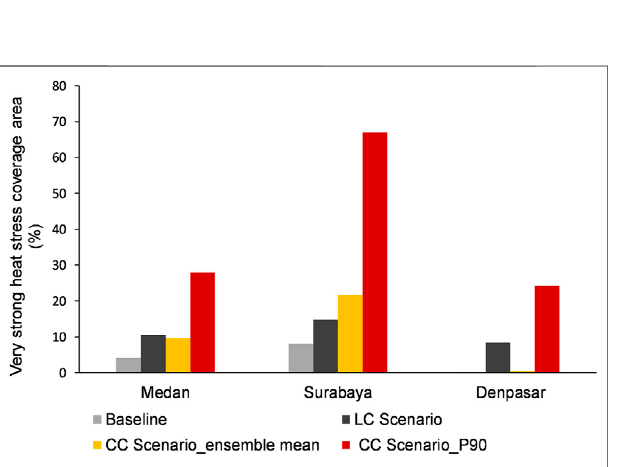
FIGURE 10 | Very strong heat stress area (UTCI > 38), CC